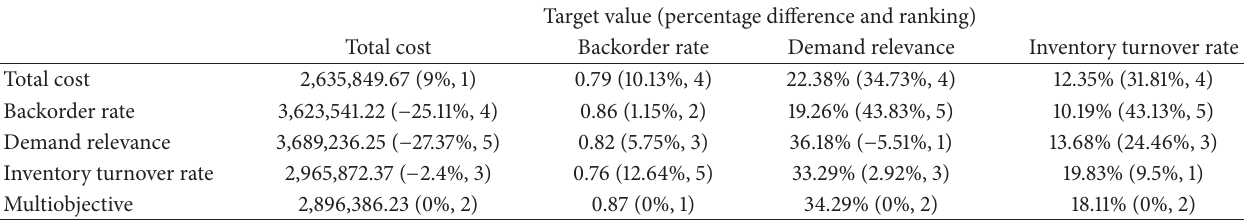
Table 4: Difference analysis of the clustering results and target values of other target equations.